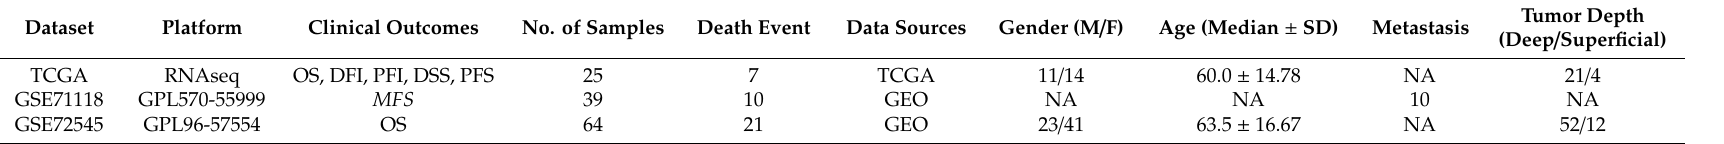
Table 1. Datasets used in Online consensus Survival analysis for Myxofibrosarcoma